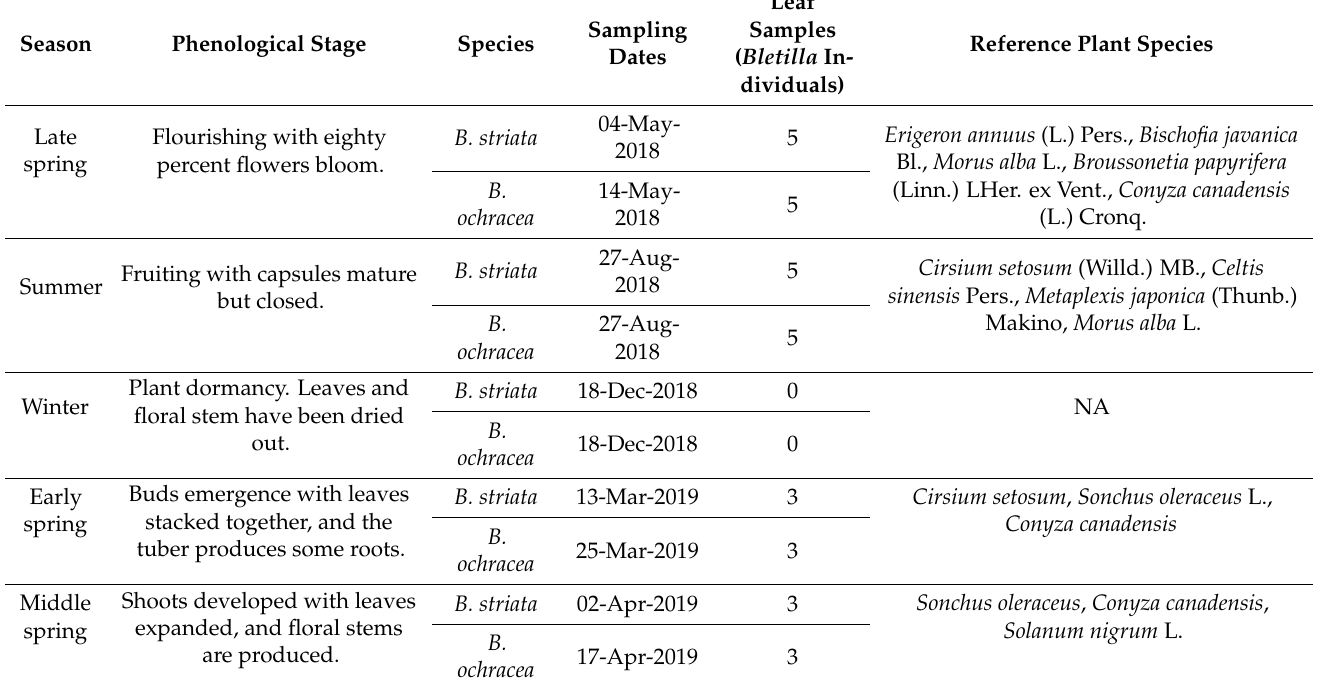
Table 2. Phenological stages and sample times of Bletilla and autotrophic reference plants.